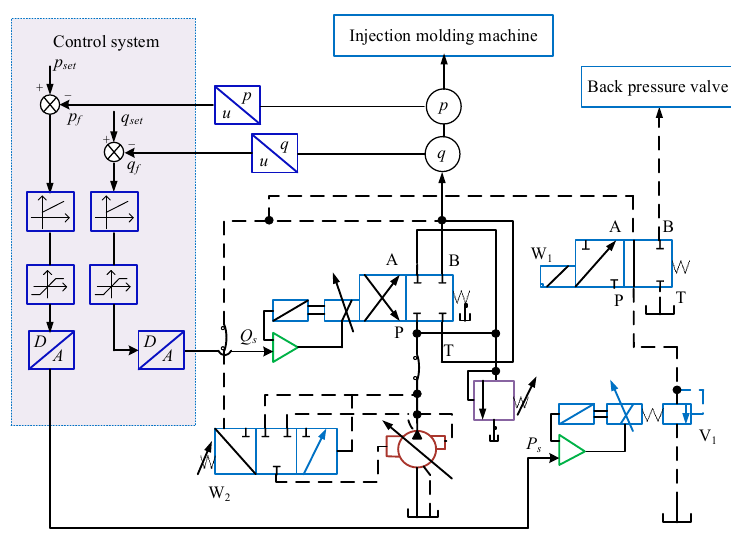
Figure 5. The schematic diagram of a load-sensing control system.